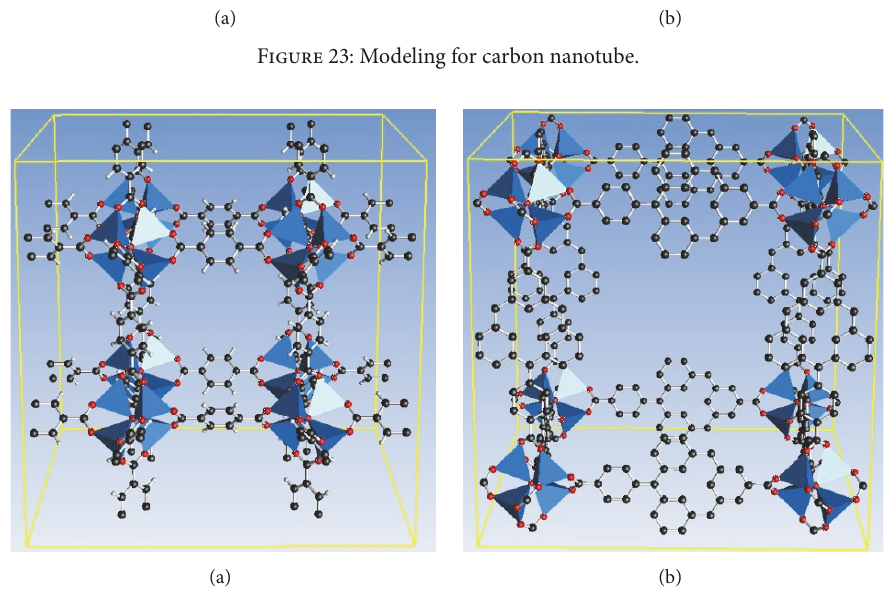
Figure 24: Modeling for